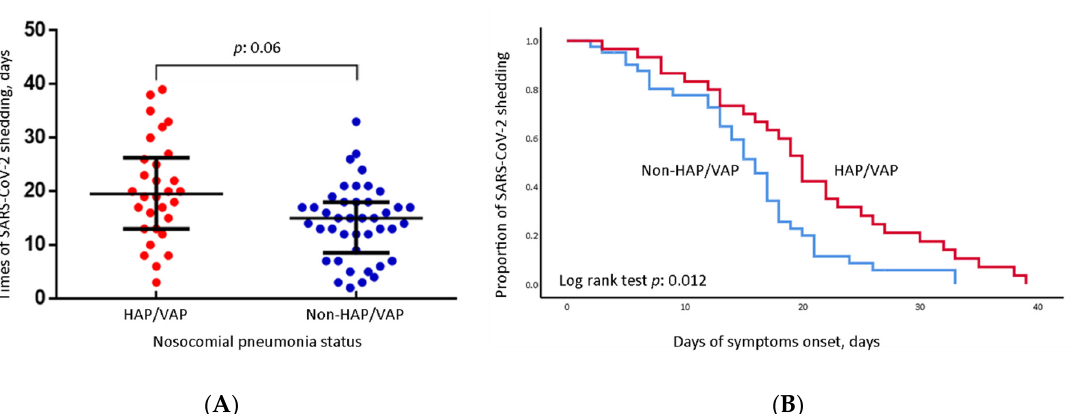
Figure 2. SARS-CoV-2 virus shedding and HAP/VAP. Red dots and lines: HAP/VAP group; Blue dots and lines: non-HAP/VAP group. ( A ) Distribution of SARS-CoV-2 virus shedding days categorized as HAP/VAP group and non-HAP/VAP group. We defined SARS-CoV-2 virus shedding as RNA quantification by the cycle threshold value (Ct value) being less than 30 with the open reading frame lab (ORFlab) gene as the target gene. ( B ) Patients in the HAP/VAP group had a significantly longer duration for SARS-CoV-2 virus shedding (Log rank test: p = 0.012).